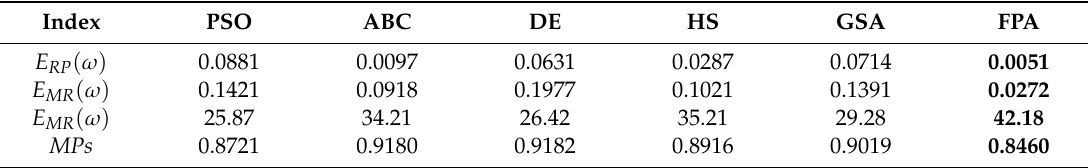
Table 5. Performance comparison of the filter characteristics. The results correspond to the responses of each of the best filters produced by every algorithm PSO, ABC, DE, HS, GSA and FPA (reported in Table